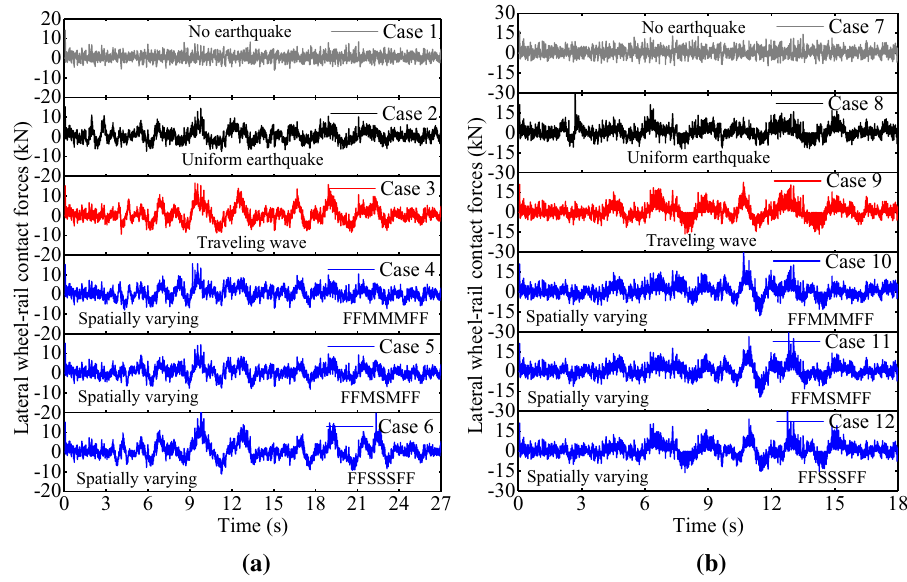
Fig. 14 Time histories of the lateral wheel–rail contact forces of the first left wheel: a cases 1–6; b cases